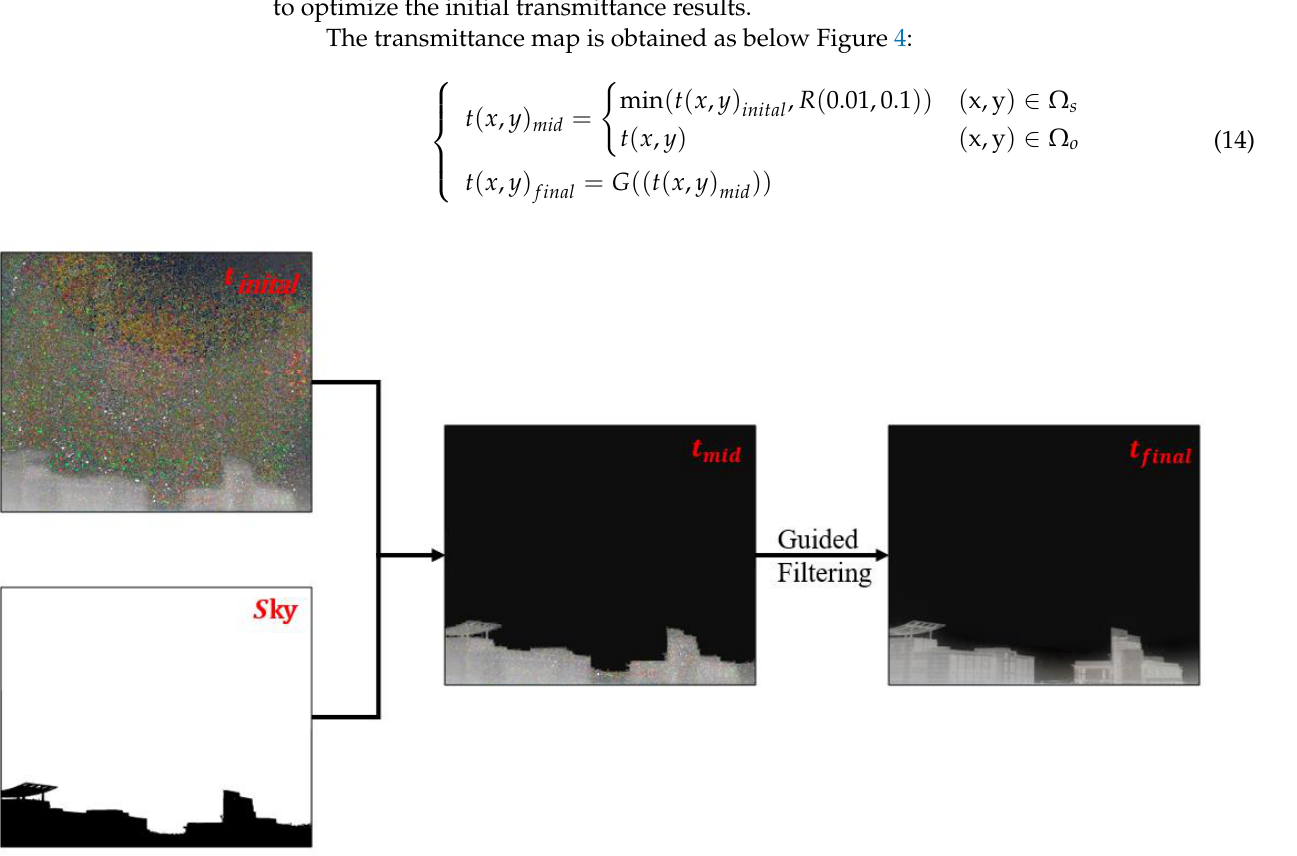
Figure 4. The optimization process of the transmittance map. R In the above formula, stands for the random assignment. s represents the sky G region, o represents the object region, and represents the guided filtering.